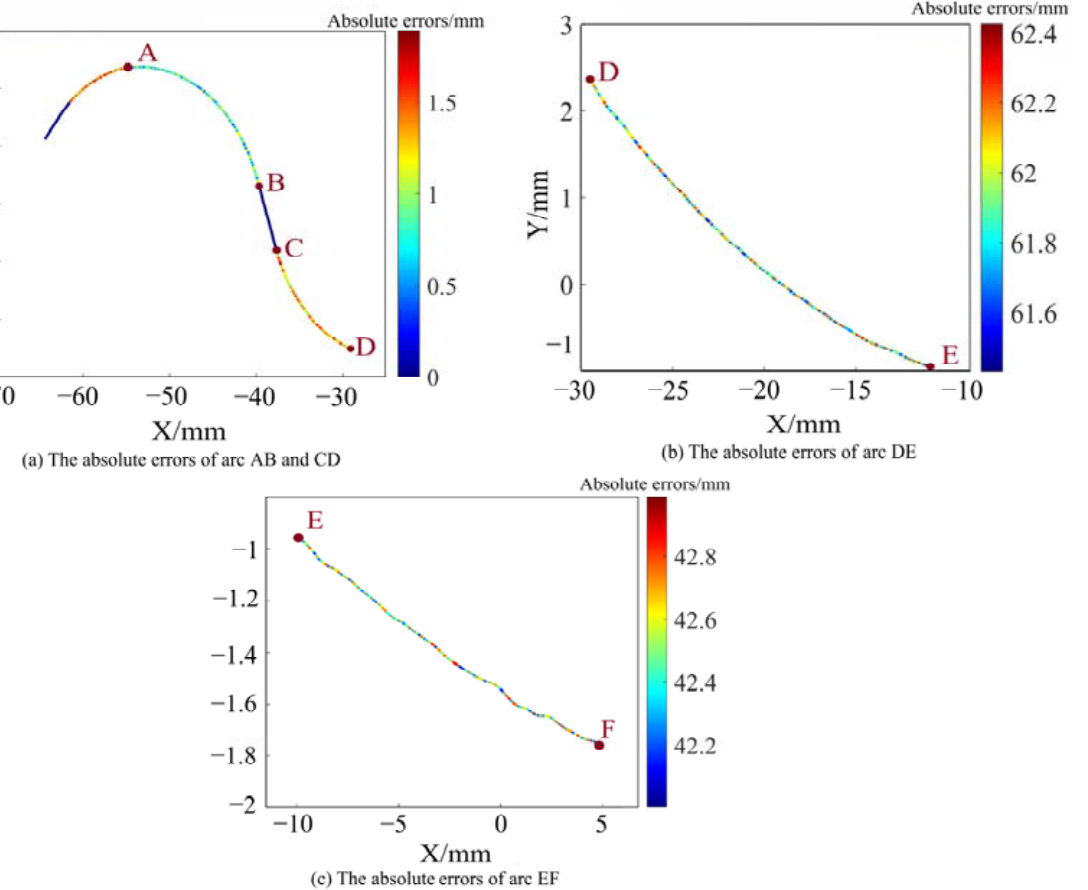
Figure 12. Absolute errors of radii of curvature for all points in the LM A -type wheel profile.